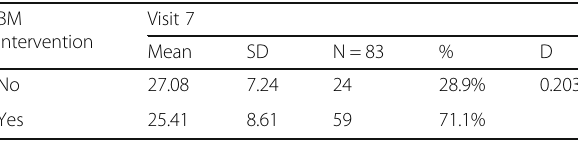
Table 4 Effect size of the global BOMET-QoL-10 mean values at visit 7 in patients receiving specific treatment for BM vs those who did